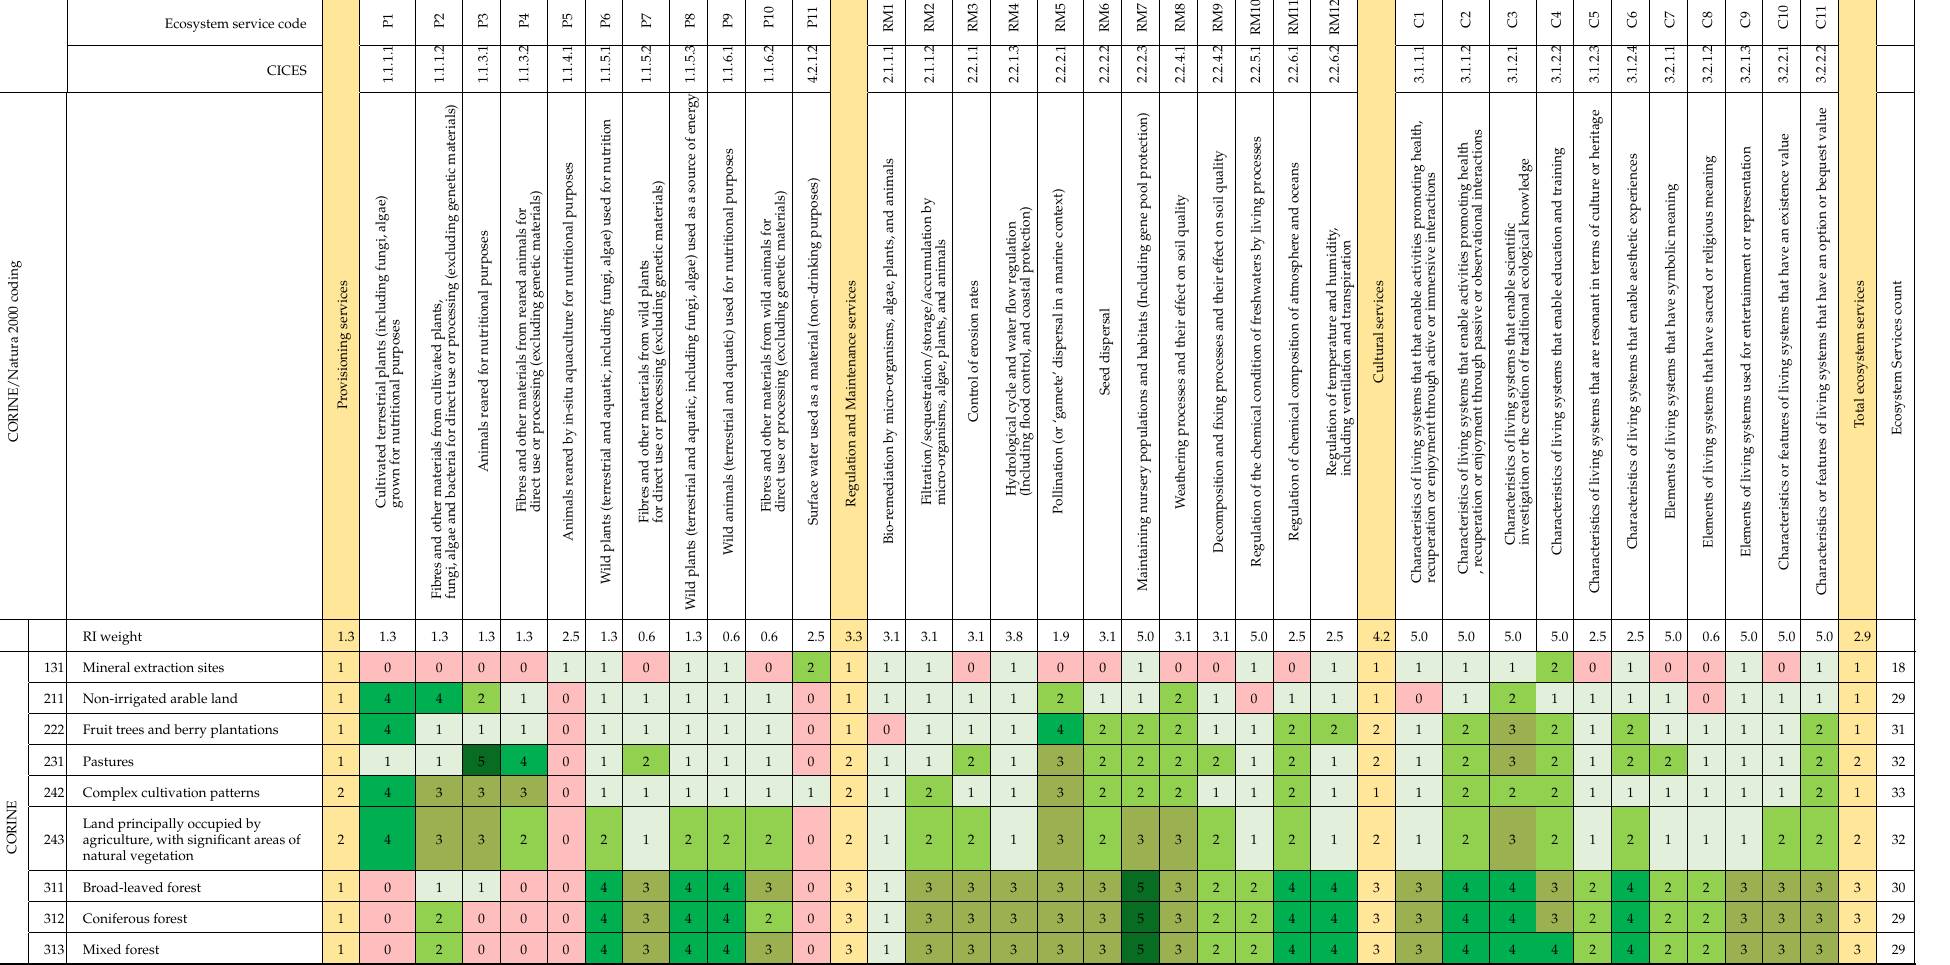
Table 2. Ecosystem services matrix filled with the average values of the expert-based assessment. The values follow the scale: no potential = 0, low relevant potential = 1, relevant potential = 2, medium potential = 3, high potential = 4, very high potential = 5, highlighted with a color scheme where dark green indicates higher values. Yellow columns represent ES categories with calculated RI weighted average for land cover